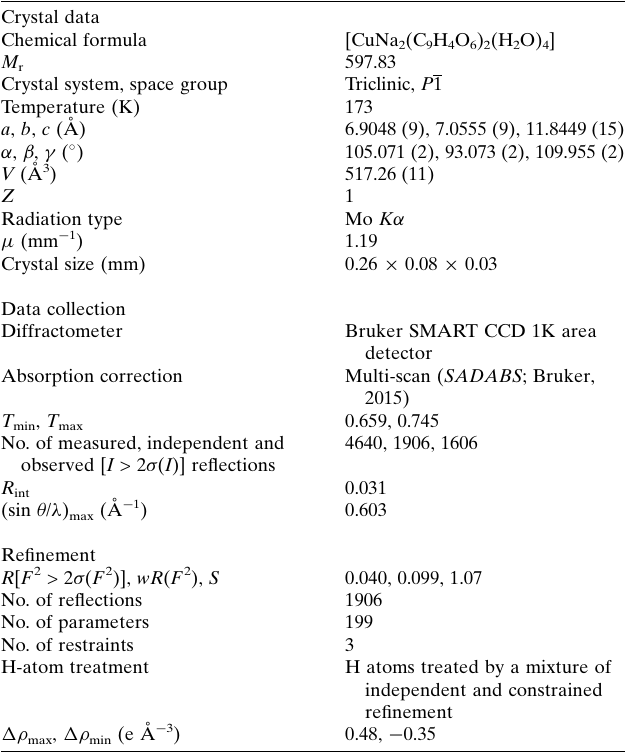
Table 3 Experimental details. Crystal data Chemical